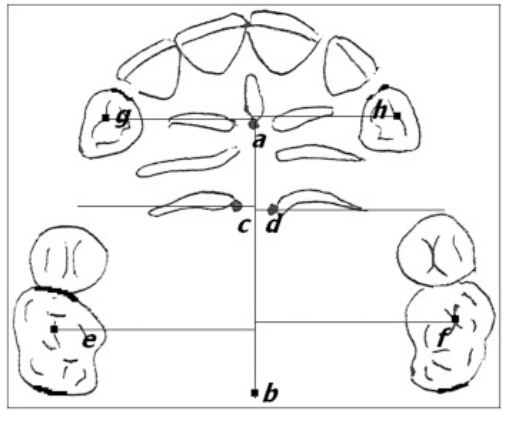
Figure 3. Landmark points.